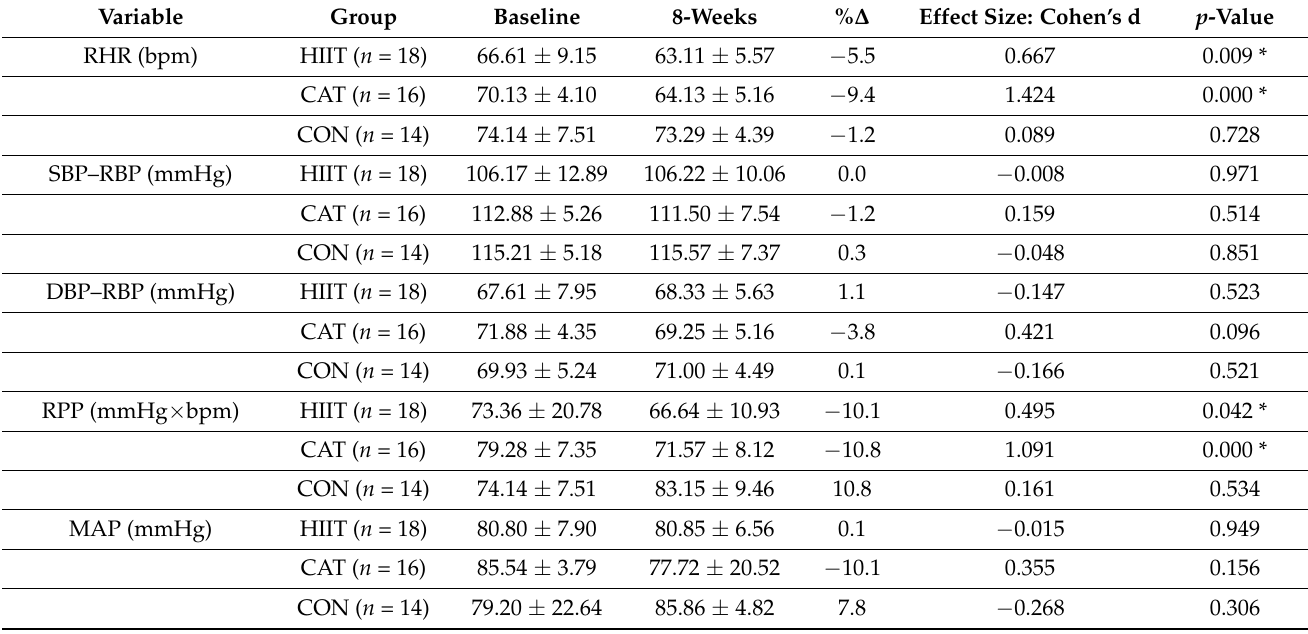
Table 2. Resting heart rate, systolic BP—resting blood pressure, diastolic BP—resting blood pressure, rate pressure product and mean arterial pressure in college-aged smokers following 8 weeks of high-intensity interval training (HIIT), continuous aerobic training (CAT), and a control group